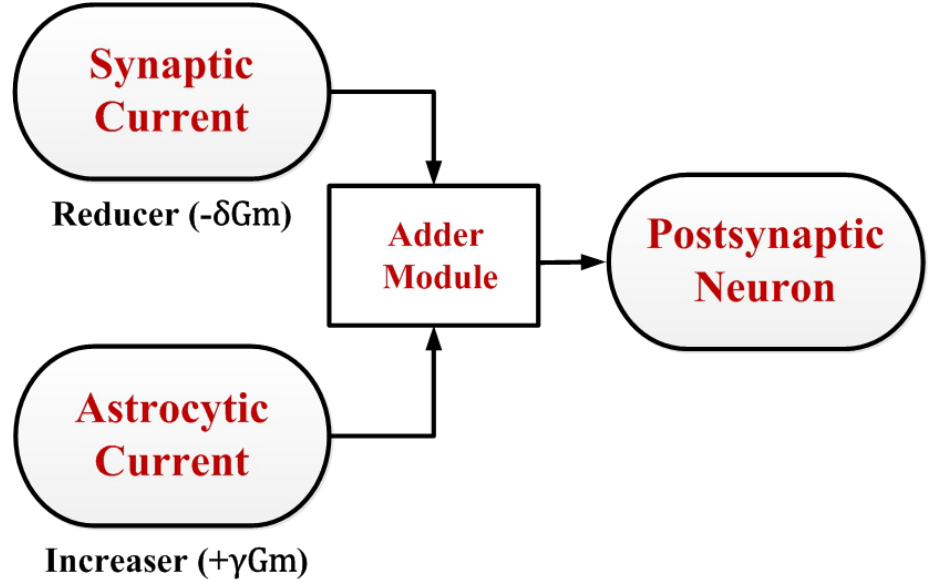
Figure 3. Input excitation current of post-synaptic neuron that is created by the synapse and astrocyte at the same